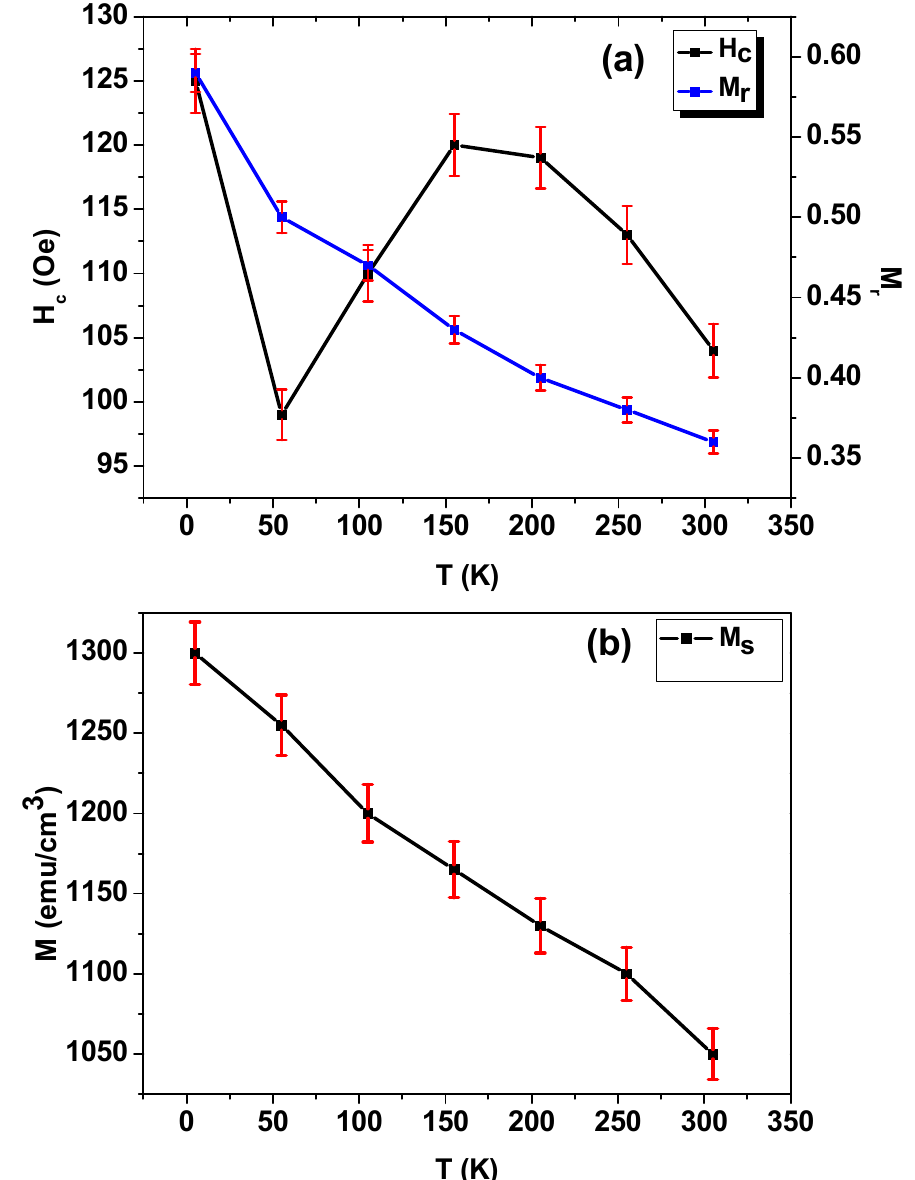
Figure 4. Coercivity (H c ) and normalized remanent (M r ) ( a , b ) magnetization saturation (M s ) of the as-prepared Co 2 MnGe glass-coated microwire dependence on temperature.